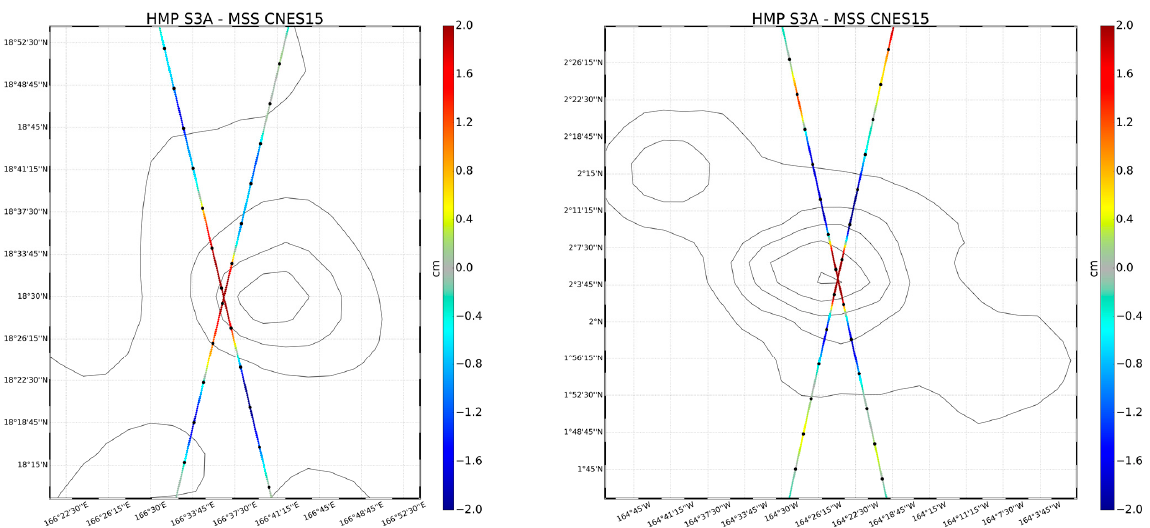
Figure 2. Differences between the full-rate (20 Hz) S3A HMP and the CNES_CLS15 gridded reference MSS over two seamounts. Bathymetric contours at 1000 m intervals are shown as black lines. Black dots illustrate the 1 Hz sampling. Unit is cm.